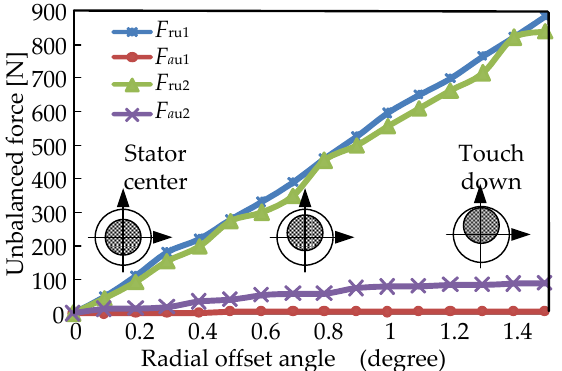
Figure 13. Radial offset angle versus and radial unbalanced force.